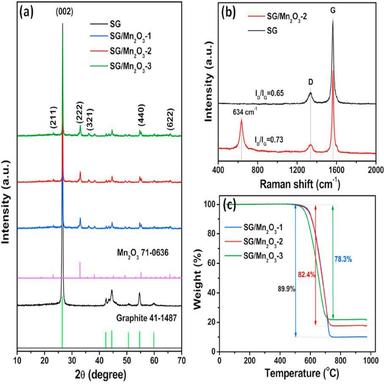
XPS spectra of (a) survey spectrum, (b) C1s, (c) O1s and (d) Mn2p.